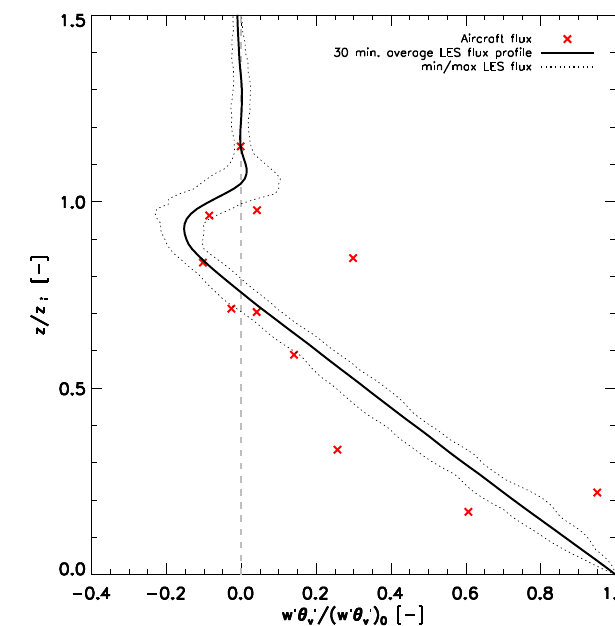
Figure 12. Same as Fig. 11, but now for the latent heat flux.